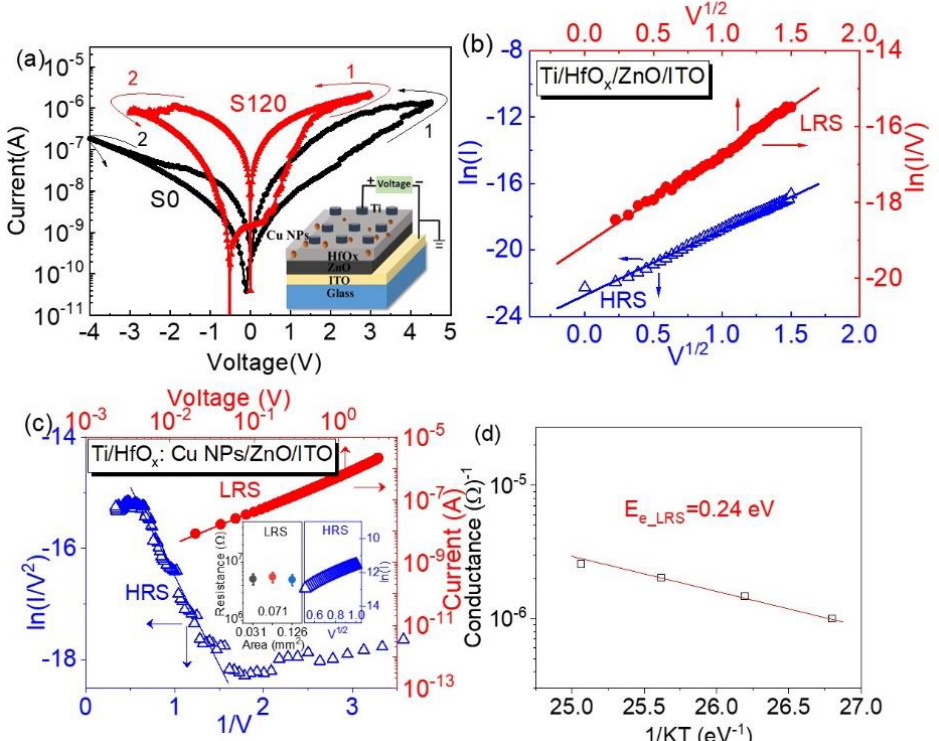
Figure 2. ( a ) Current–voltage characteristics of the stacked layers with the inset of schematic diagram of device structure and measurement configuration; ( b ) ln( I )- V 0.5 and ln( I / V )- V 0.5 fittings for the HRS and LRS of device S0; ( c ) ln( I / V 2 )-1/ V and log( I )-log( V ) fittings for the HRS and LRS of device S120. The right inset is the ln( I )- V 0.5 fitting of the HRS at low electrical field, while the left inset is the LRS resistance vs. device area. ( d ) Conductance vs. 1/KT for the LRS device with Cu